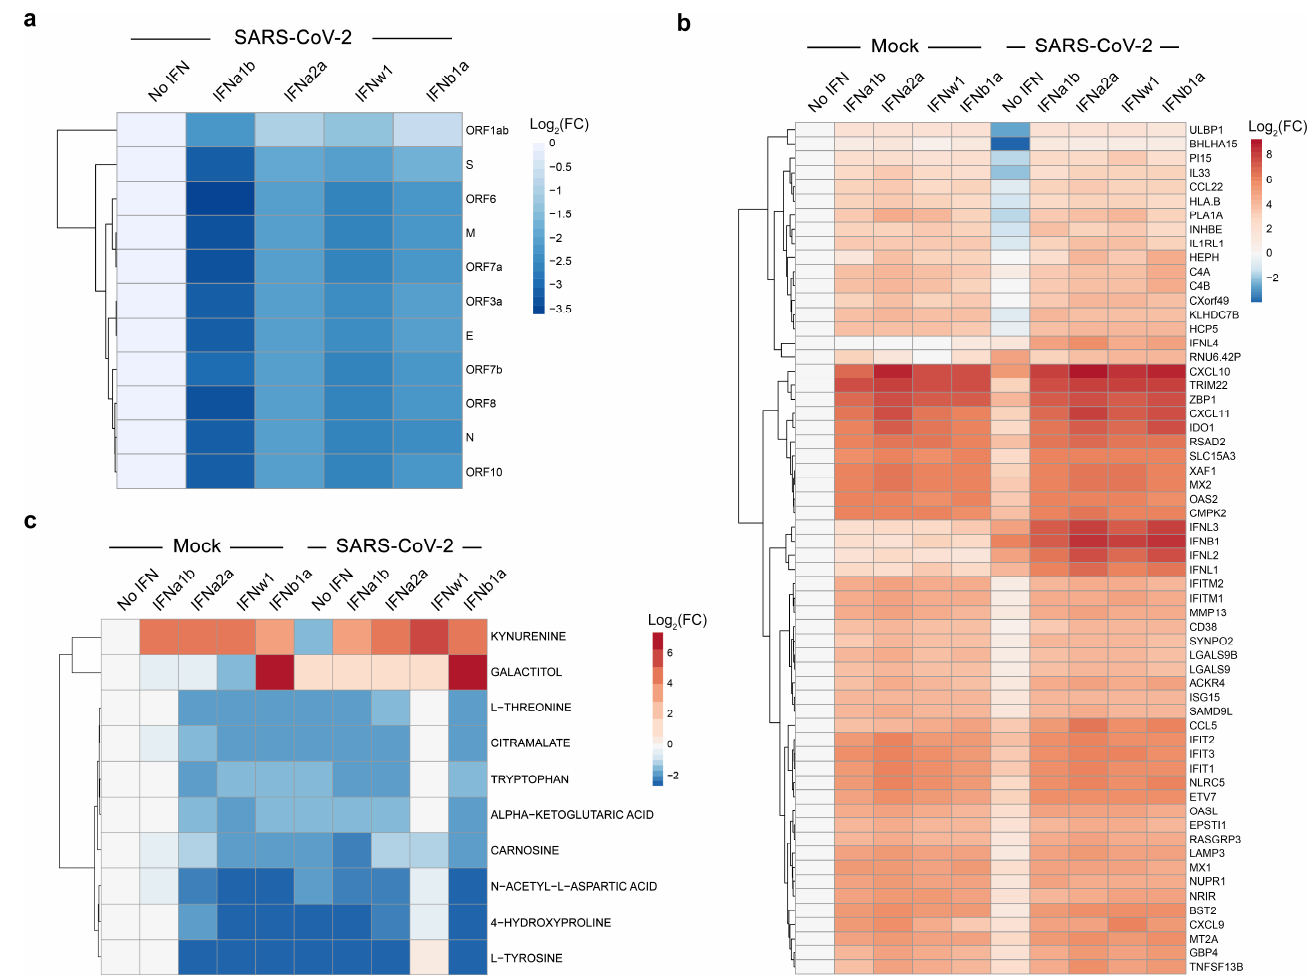
Figure 4. Transcriptomic and metabolomic analyses of mock- and SARS-CoV-2-infected Calu-3 cells, non-treated or treated with type I IFNs. ( a ) Calu-3 cells were stimulated with IFNs (1 μg/mL) or non-stimulated, and infected with SARS-CoV-2 (moi = 0.01). A heatmap of viral RNAs affected by treatment is shown. Each cell is colored according to the log2-transformed expression values of the samples, expressed as fold-change relative to the non-treated control. ( b ) Calu-3 cells were either stimulated with recombinant human IFN (1 μg/mL) or left untreated with IFN, then infected with either mock or SARS-CoV-2 (moi = 0.01). A heatmap of the most variable cellular genes affected by treatment and virus infection is shown. Each cell is colored according to the log2-transformed expression values of the samples, expressed as fold-change relative to the non-treated, mock-infected control. ( c ) Cells were treated as for panel b. After 24 h, the cell culture supernatants were collected, and metabolite levels were determined by LC-MS/MS. A heatmap of the most-affected metabolites is shown. Each cell is colored according to the log2-transformed profiling values of samples, expressed as fold-change relative to the mock control.